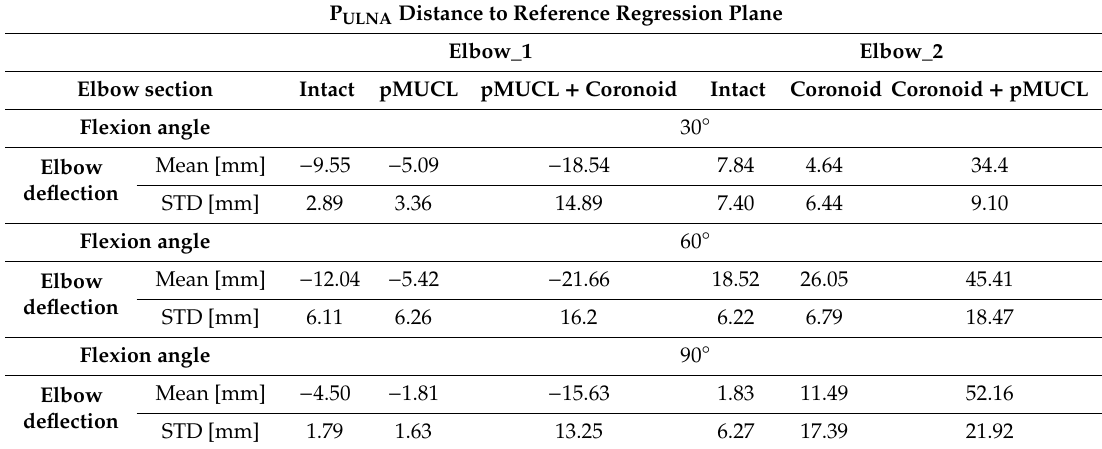
Table 2. Elbow_1 and Elbow_2 deflection results in terms of mean and standard deviation (STD) values. P ULNA Distance to Reference Regression